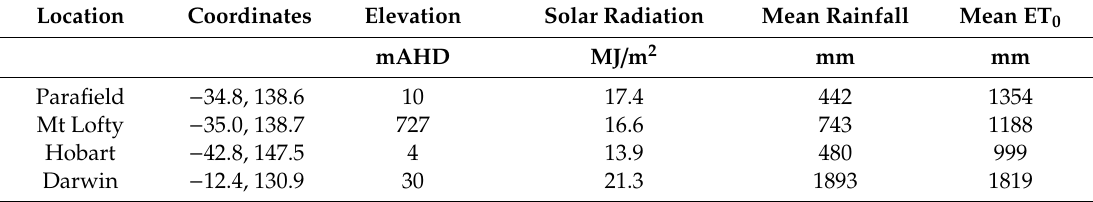
Table 4. Climate parameters for modelled locations from historical data set, 2009–2018